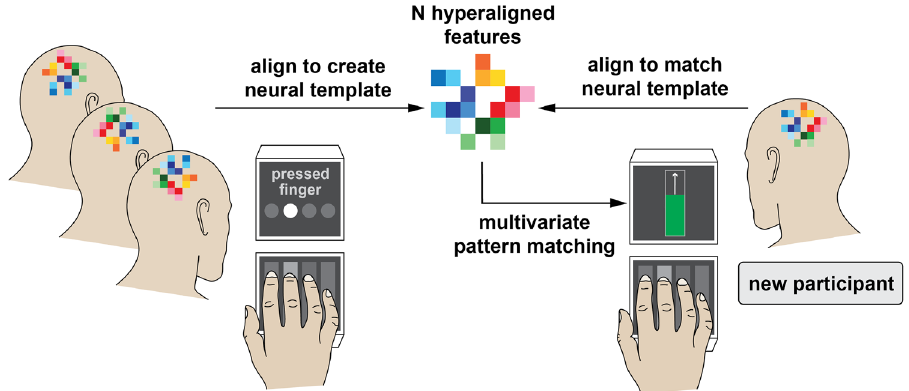
Figure 1. Overview of functional-based alignment. Neural patterns are rotated from subjects’ native space into a common template space. This template can then serve as a surrogate neurofeedback training target for a new participant who is unable to create an autologous target due to neurological